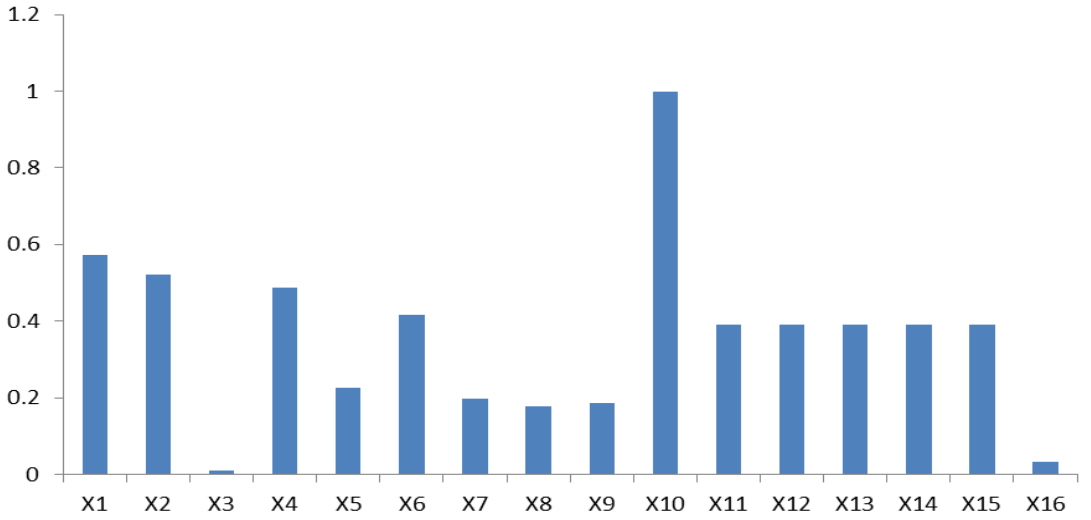
Figure 8. Q value of each factor’s influence on habitat quality.